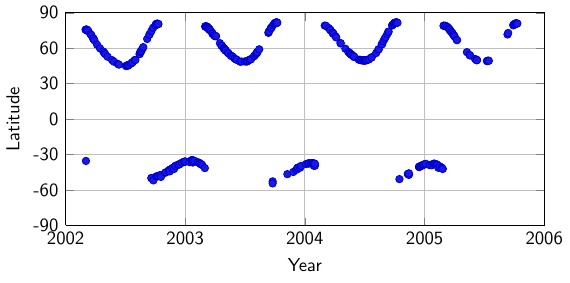
Fig. 12. Location of the SAGE III/OSIRIS coincident measurements as a function of time and latitude.